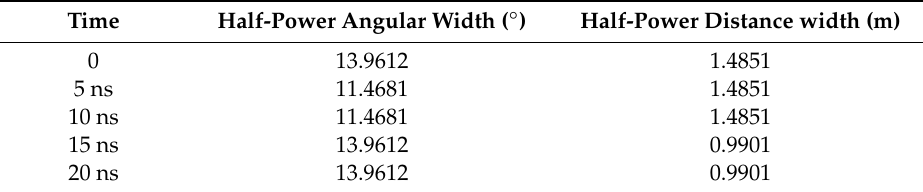
Table 2. Values of the